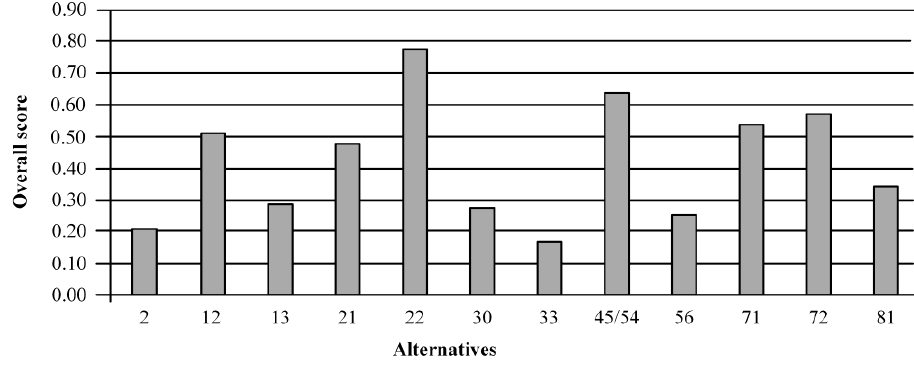
Fig. 9. Ranking “Energy block”